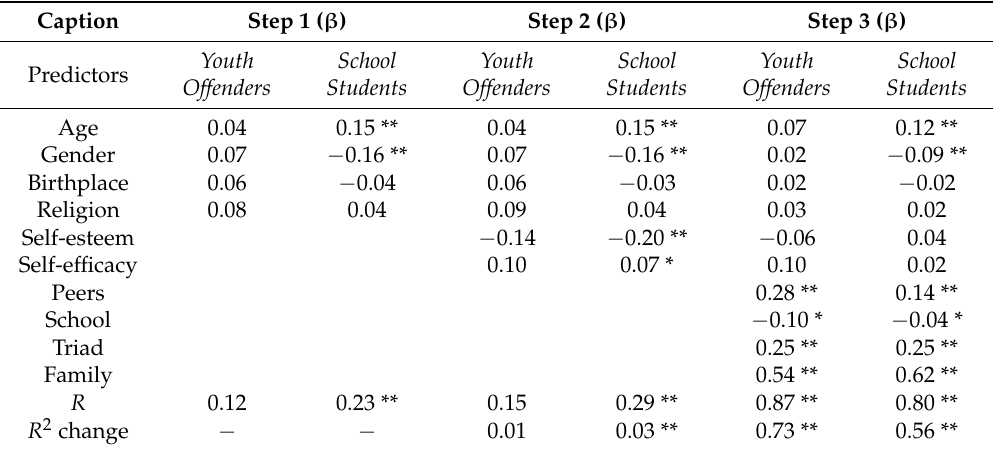
Table 4. Hierarchical regression analysis of violent behavior predicted by self and contextual